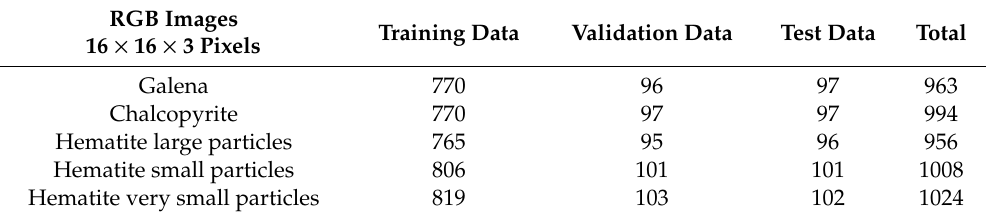
Table 2. Data set of the RGB images.